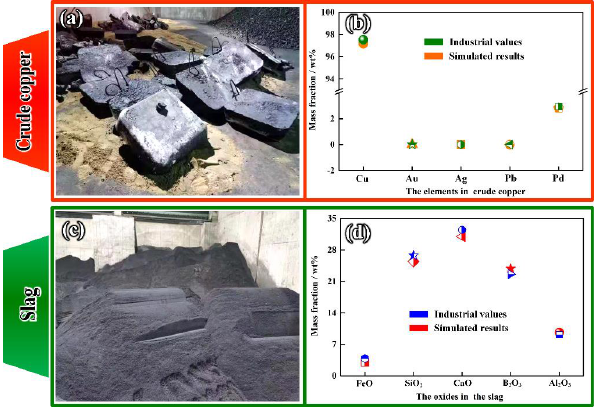
Figure 5. The comparisons between industrial values and simulated results: ( a ) photograph of the crude copper produced by the enterprise; ( b ) comparison of the elements in crude copper; ( c ) picture of the slag produced by the same enterprise; ( d ) comparison of the oxides in the slag.